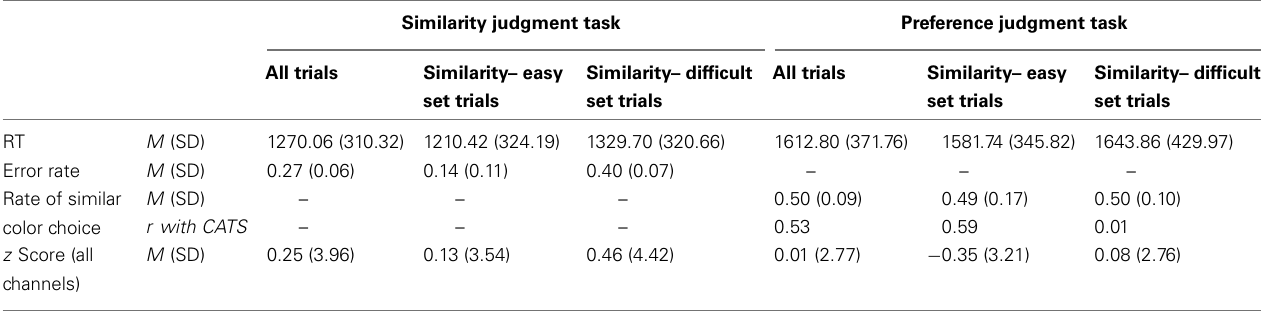
Table 3 | Summary of behavioral data and averaged z score cross all NIRS channels for each task and each stimulus-set condition. Similarity judgment